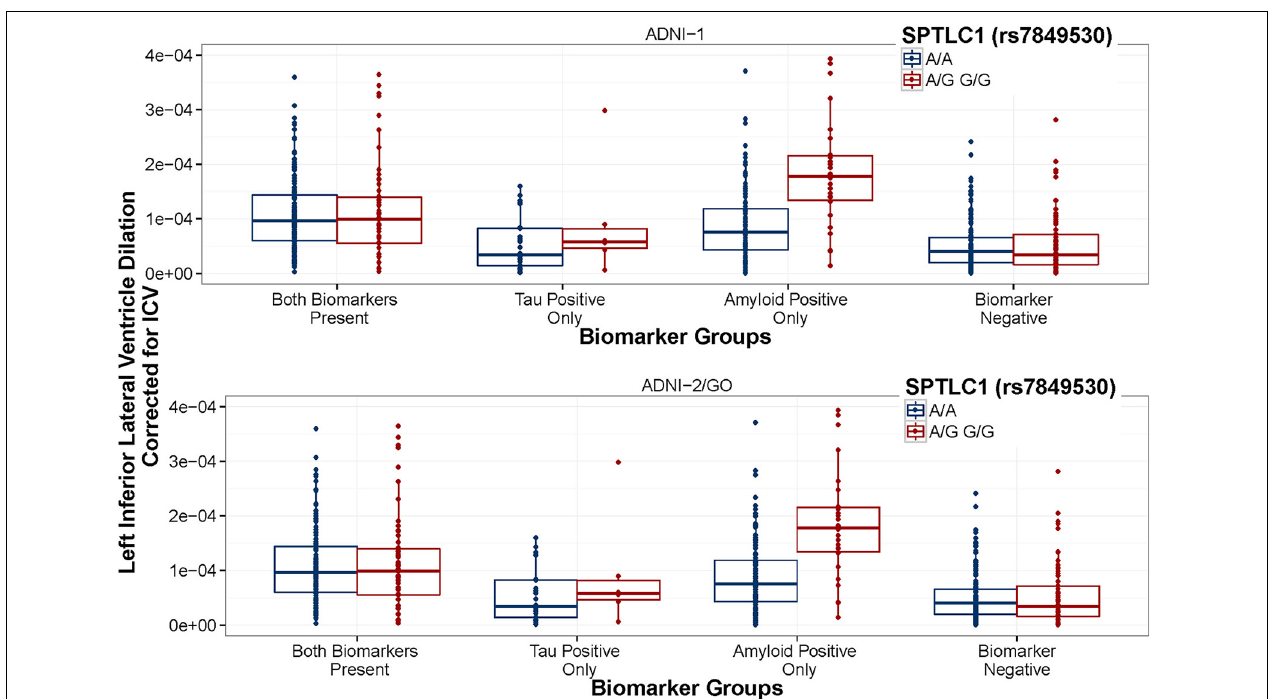
FIGURE 3 | SPTLC1 (rs7849530) interaction is consistent between datasets. ADNI-1 data are presented in the top panel. ADNI-2/GO data are presented in the bottom panel. Biomarker groups are presented on the x-axis and annual change in the left inferior lateral ventricle is presented on the y-axis. Boxplots are grouped by